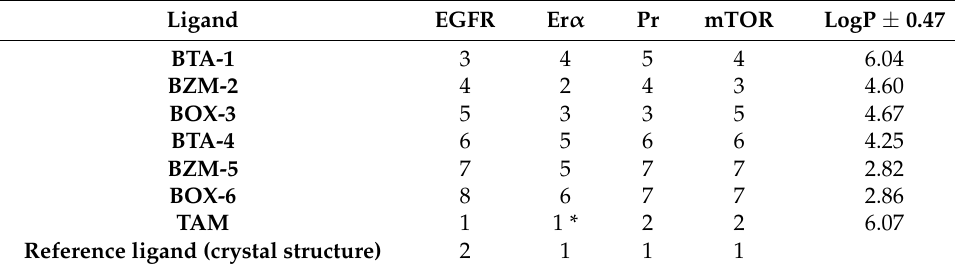
Table 5. Exponential rank consensus between receptors and derivatives of benzo [ d ] [1,3] azole. * The tamoxifen (TAM) was the crystal ligand of Er α and LogP calculated by Crippen (cid:48) s fragmentation method